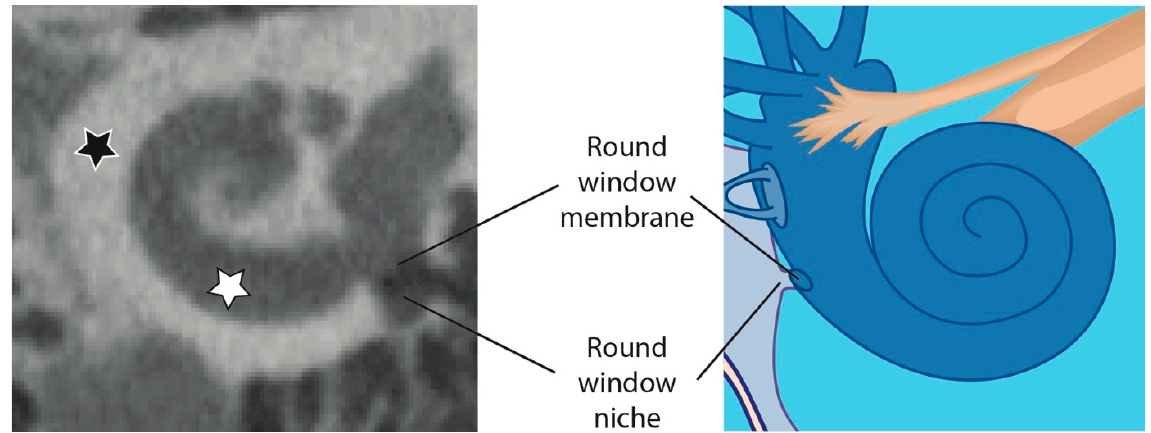
Figure 2. Overview of the human cochlea in a CBCT image ( left ) compared to an illustration of the cochlea ( right ). The white star marks the fluid filled cochlea which is surrounded by radio dense hard bone (black star). The RWN is also surrounded by hard bone and the volume of the RWN is mainly air filled (as shown in the CBCT image on the left) but can also be fluid filled or obstructed by tissue.